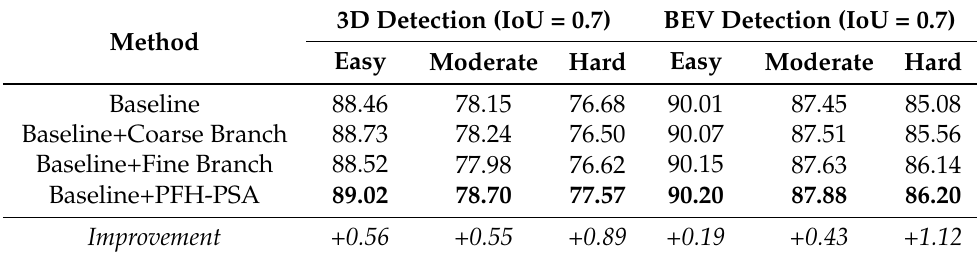
Figure 6. The average precision (AP) (%) of different methods on the KITTI validation set. Table 2. Performance comparison of different backbone networks on the KITTI validation